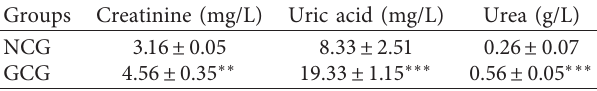
Table 1: Comparison of the renal biomarkers of the animal models.